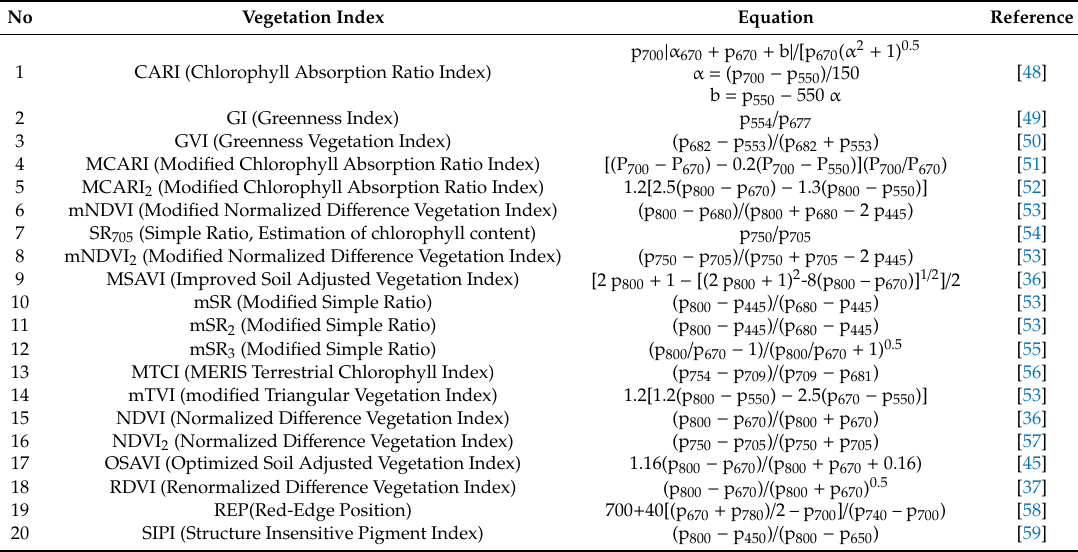
Table A2. Hyperspectral vegetation indices used in the